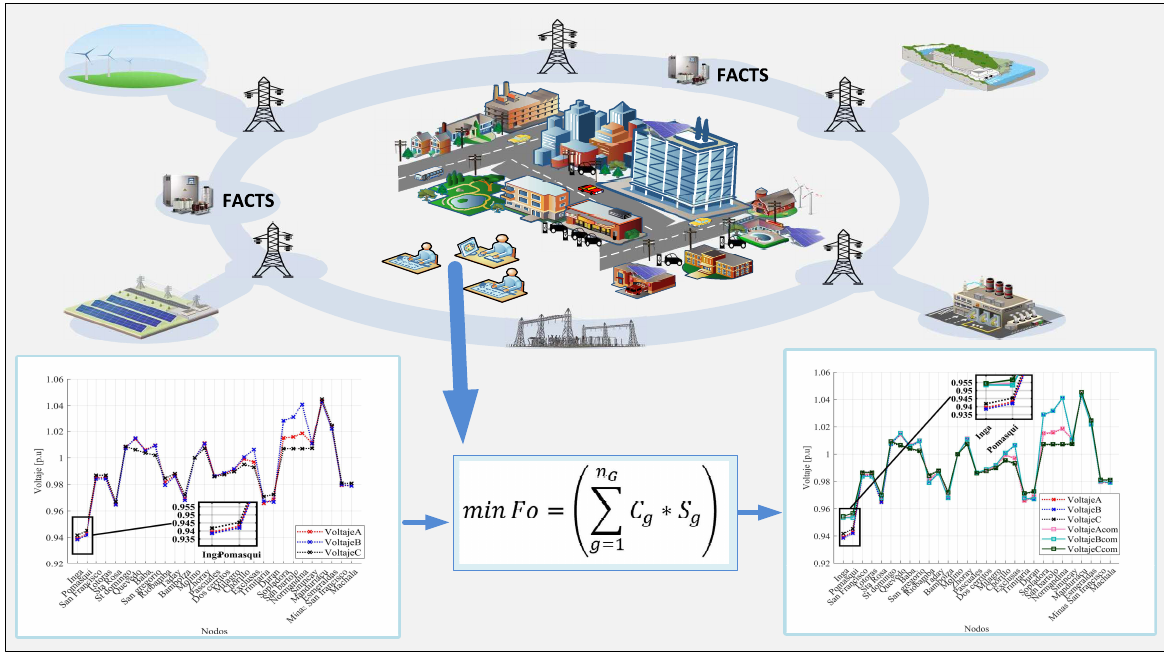
Figure 1. Reactive compensation architecture under unbalanced flows